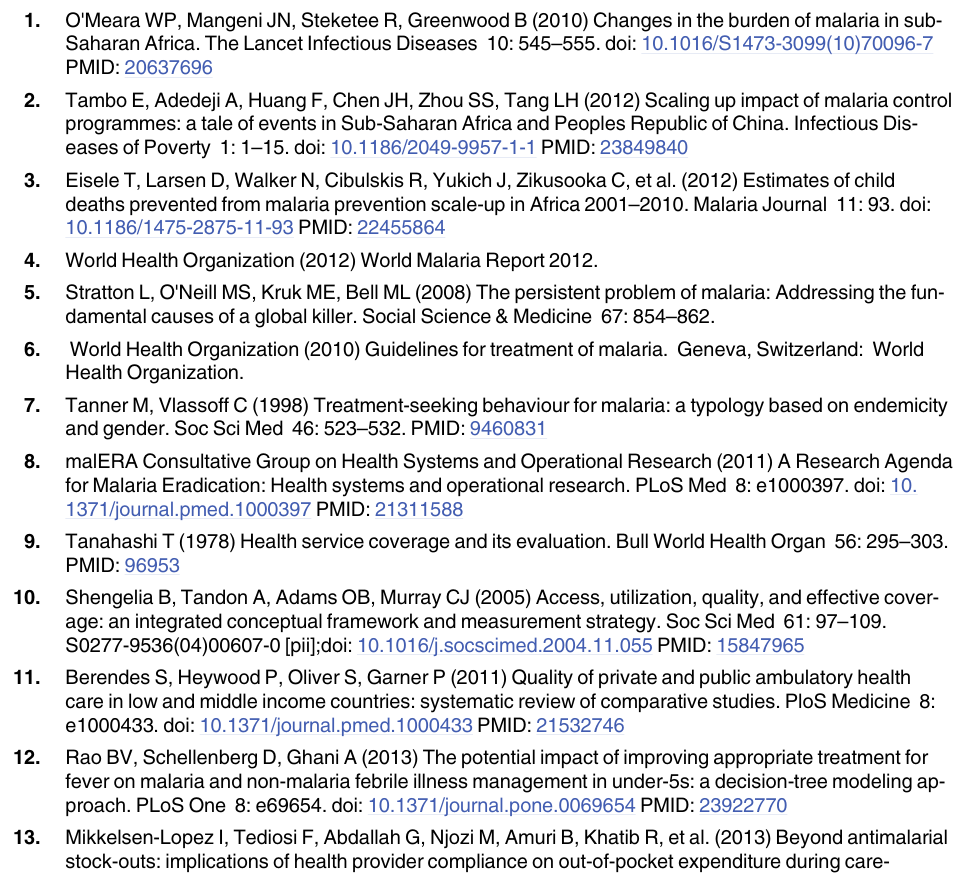
S3 Table. Data Sources and Point Estimates of Adherence with the First-Line Drug Regi- men. S4 Table. Data Sources and Point Estimates of Drug Quality: ALU. S5 Table. Data Sources and Point Estimates of Drug Quality: